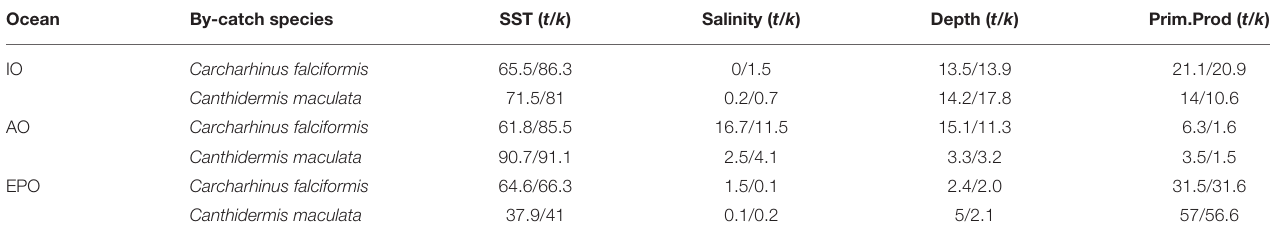
TABLE 3 | Logistitc model output values: percentage of contribution of each environmental variable with all observations ( t ) and cross-validated ( k ) for Carcharhinus falciformis and Canthidermis maculata in the Indian (IO), Atlantic (AO), and Eastern Pacific Ocean (EPO). Ocean By-catch